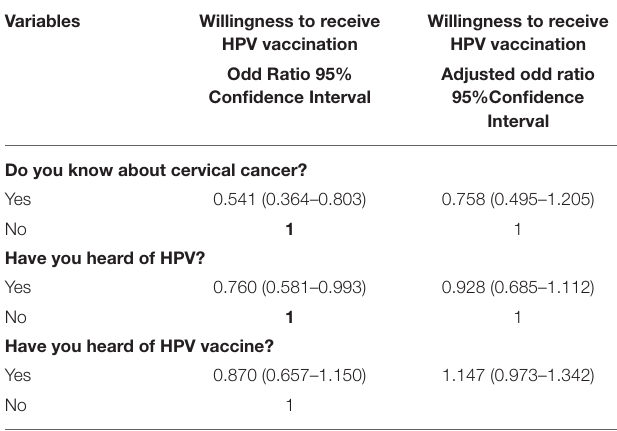
TABLE 6 | Variables associated with the willingness to receive